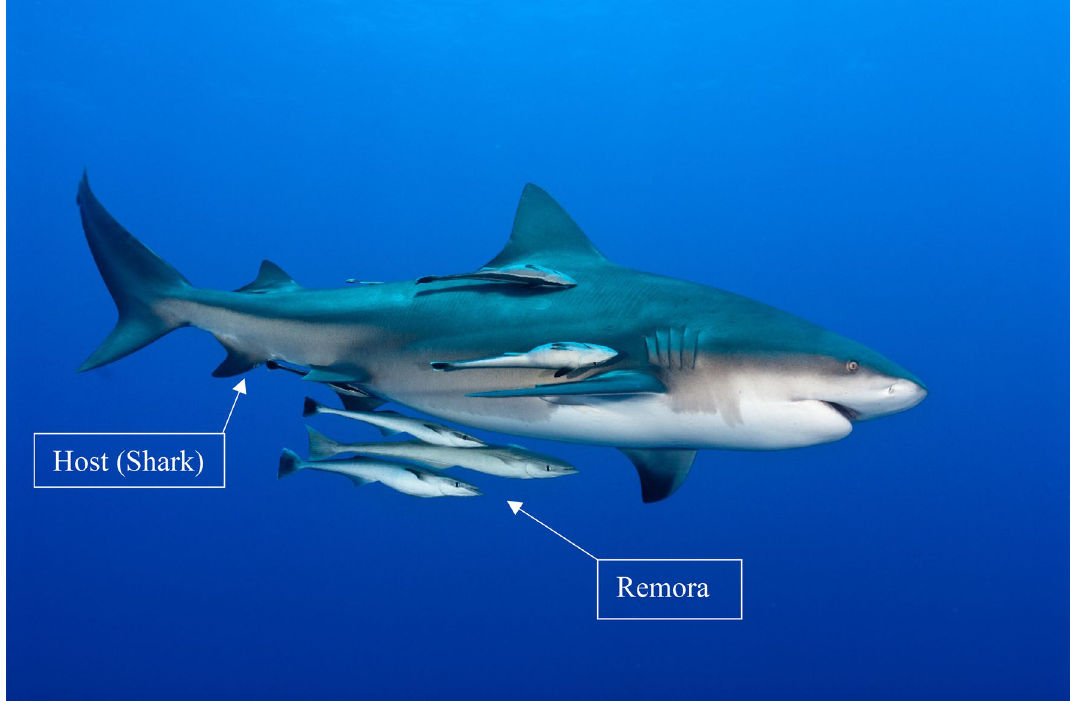
Figure 1. The attached swimming of remora with the host (created by Fiona Ayerst/Shutterstock.com).